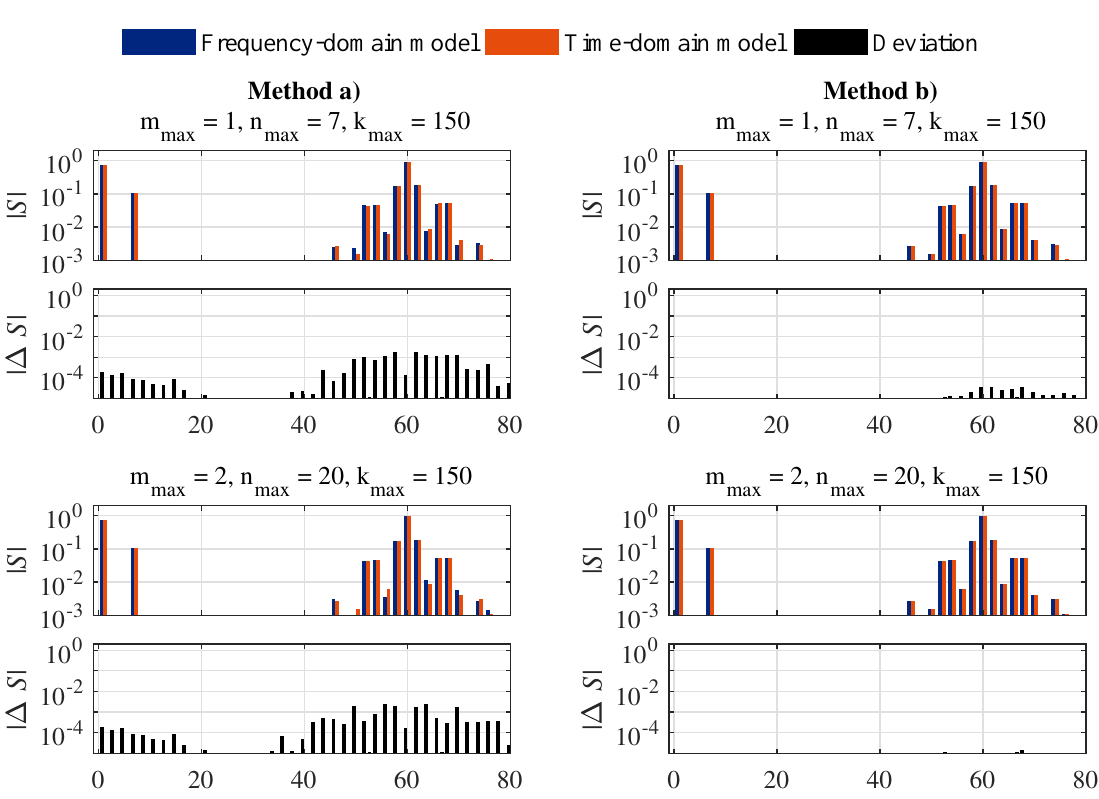
Figure 10. Evaluation of the models depicted in Figure 6a (left graphs) and Figure 6b (right graphs). The parameters m max and n max are varied from top to bottom